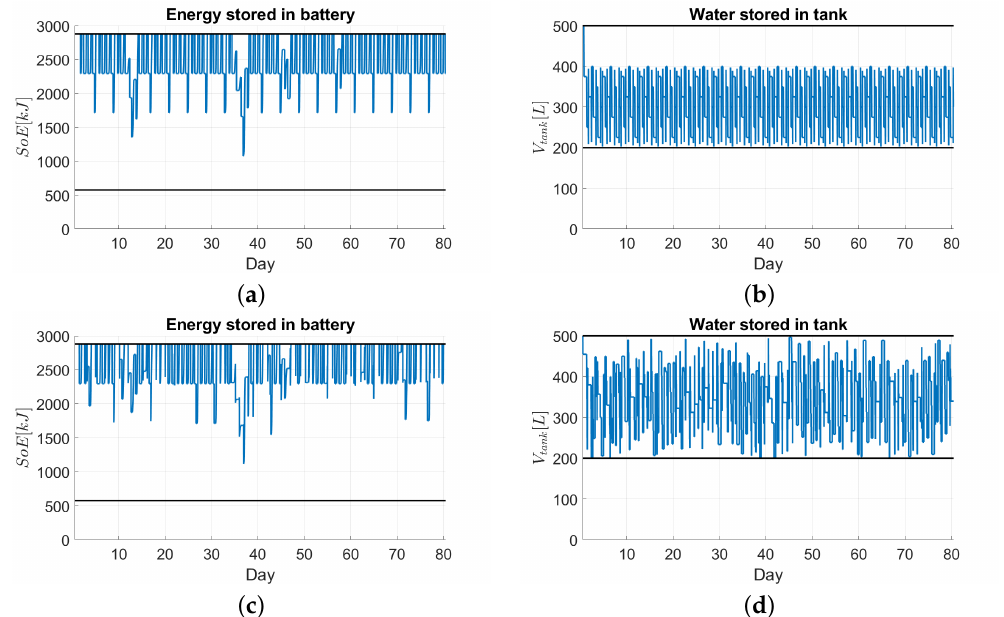
Figure 10. Energy and water stored in the greenhouse components during the simulations. These resource availability results correspond to the values obtained using climate data from the winter season. Here, the storage limits are represented by black lines. ( a ) State of energy (SoE) of the battery in the manual irrigation scenario; ( b ) water volume stored in the tank V tank in the manual irrigation scenario; ( c ) state of energy (SoE) of the battery in the EMS irrigation scenario; ( d ) water volume stored in the tank V tank in the EMS irrigation scenario.